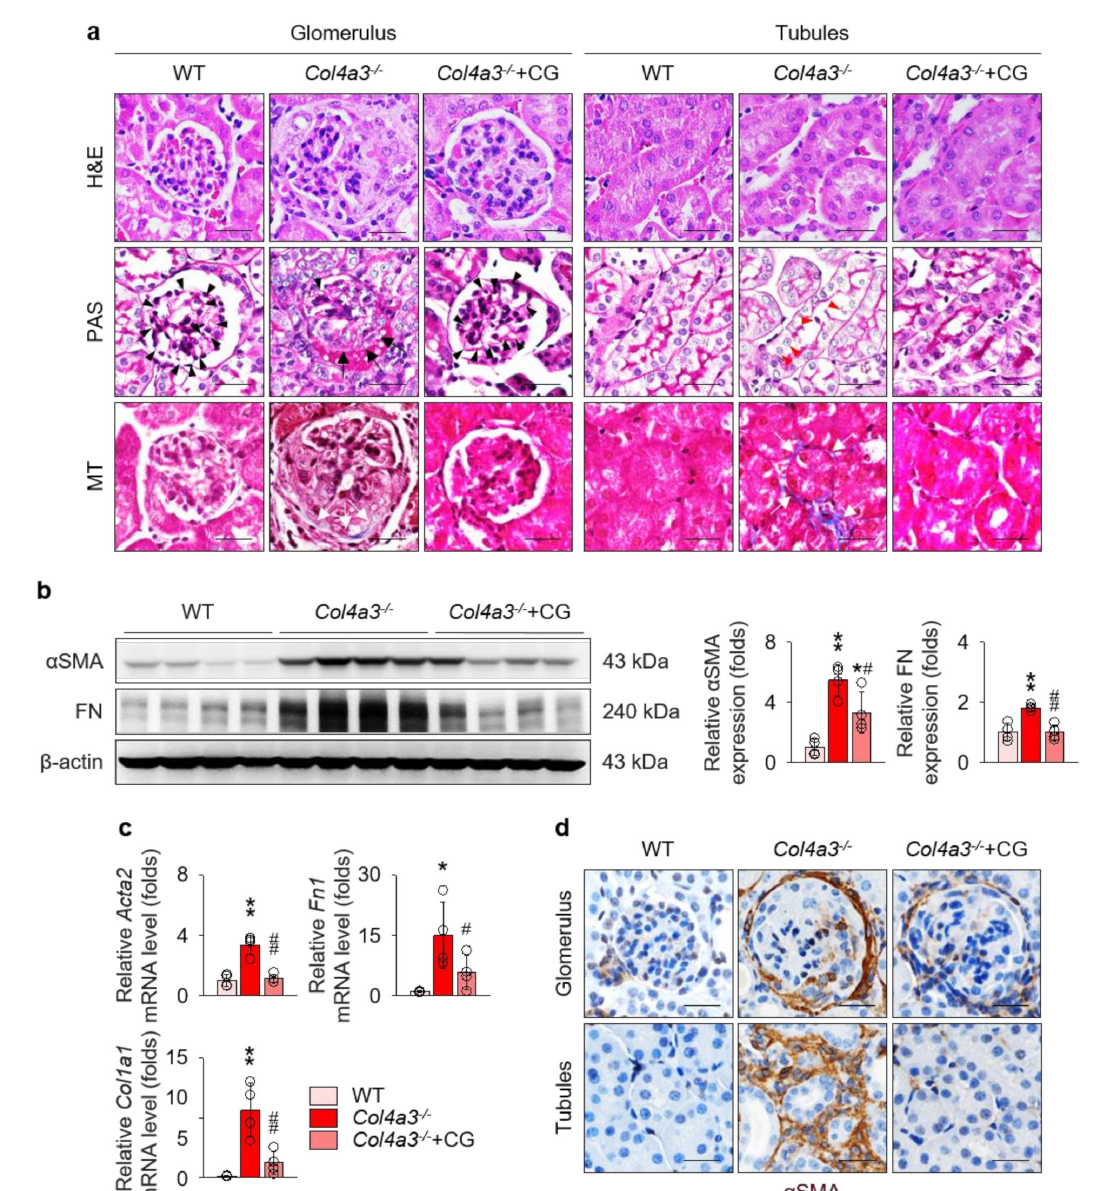
Figure 2. CG alleviated kidney fibrosis in Col4a3 − / − mice. ( a ) Tissue morphology of kidney from WT, Col4a3 − / − , and Col4a3 − / − + CG mice. Images from glomerulus (left) and tubulointerstitium (right) are presented. H&E, hematoxylin and eosin staining; PAS, periodic acid Schi ff staining; MT, Masson’s trichrome staining. Note that, contrary to kidneys from the other groups, glomerular capillary lumens were barely patent (arrowheads) with shrinkage of mesangium (white asterisk) in Col4a3 − / − mice. In Col4a3 − / − mice, crescents were packing the Bowman’s space (arrows). Detachment of tubular epithelial cells from basement membrane (red arrowheads) and collagen deposits (white arrows) are also indicated. Scale bars, 50 µ m. ( b , c ) Comparison of expression level for fibrosis markers determined by immunoblotting ( b ) and qPCR ( c ) from the kidney of WT, Col4a3 − / − , and Col4a3 − / − + CG mice ( n = 4 mice / group). β -actin for immunoblotting and glyceraldehyde 3-phosphate dehydrogenase (GAPDH) for qPCR were used as the endogenous controls. ( d ) Representative images of immunohistochemical staining for α smooth muscle actin ( α SMA; stained in brown) in the kidney of WT, Col4a3 − / − , and Col4a3 − / − + CG mice. Images from glomeruli (upper) and tubules (lower) are presented. Scale bars, 50 µ m. * p < 0.05, ** p < 0.01 vs. WT mice; # p < 0.05, ## p < 0.01 vs. Col4a3 − / − mice by one-way ANOVA with Newman–Keuls multiple comparison